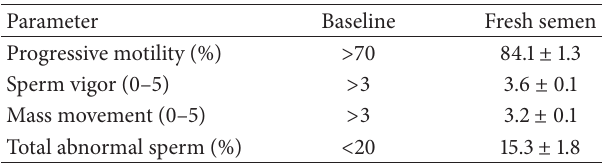
Table 1: Baseline values and characteristics of the ejaculates that were used in this study (mean ± standard error of mean).